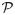
Plots of results using 4 performance measures.A: The percent of all first P that fall anywhere within the GTM for each tested algorithm and dataset. B: The percent of all first P that fall within the GTM AND within the parafovea for each tested algorithm and dataset. C: The percent of all first P that fall within the GTM AND within the parafovea AND at least 27% of the GTM (by area) lies within the parafovea for each algorithm but for only the Thorpe images. D: The percent of all first P that fall within the GTM AND within the parafovea AND at least 41% of the GTM (by area) lies within the parafovea for each algorithm but only for the Potter images.